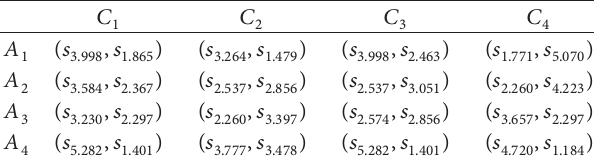
Table 1: The decision matrix 𝑅 1 given by 𝐷 1 .